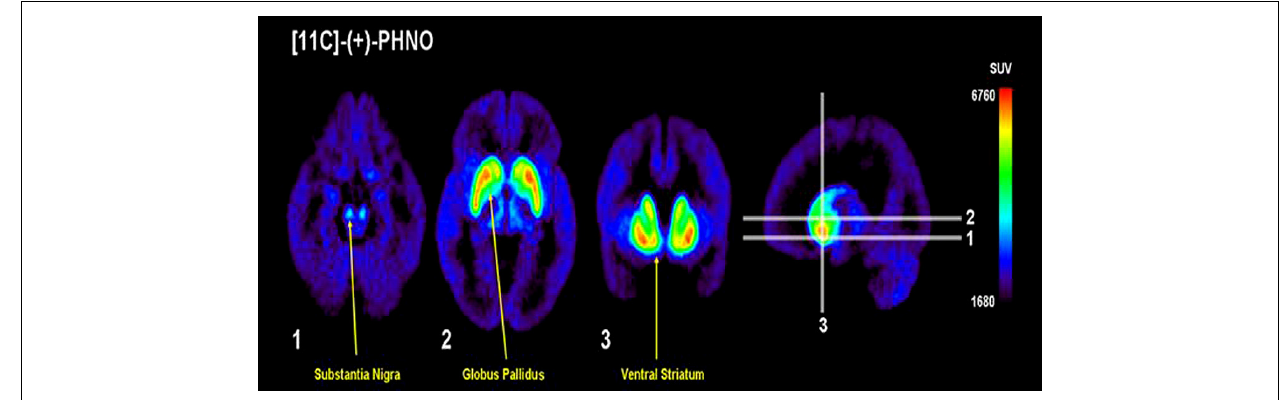
FIGURE 3 |Vizualing D3 in humans with [ 11 C]-( + )-PHNO. Uptake value mean images from 12 healthy controls. Note the preferential distribution in the substantia nigra, globus pallidus, and ventral striatum. Adapted with permission from Graff-Guerrero etal.